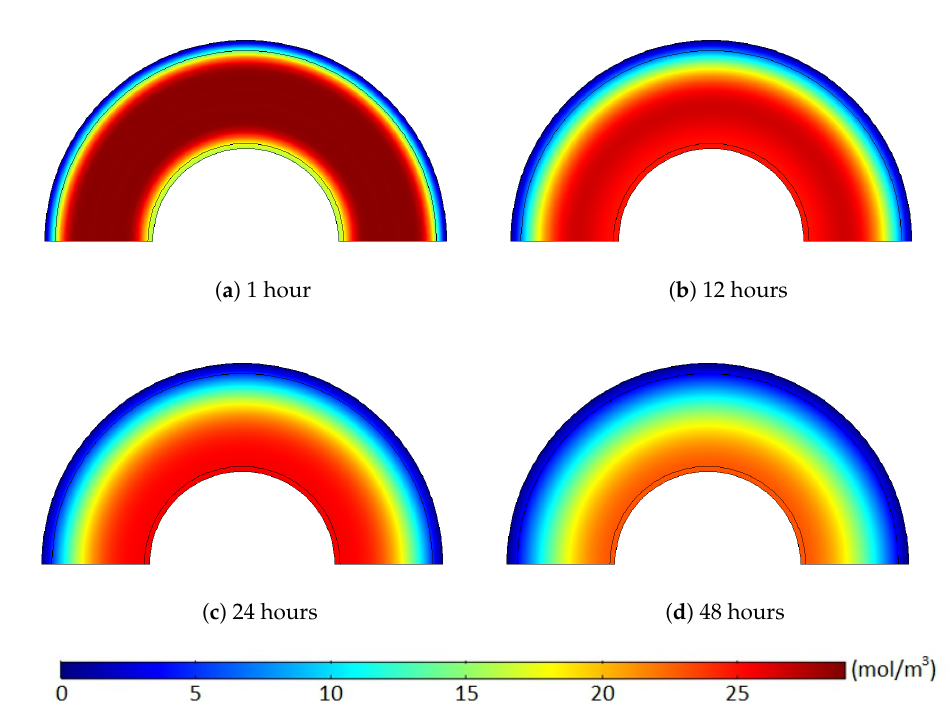
Figure 12. Methane concentration (mol/m 3 ) over time with the no-flow boundary condition where the target degassing chamber temperature is 343.15 K and C l = 1/90. ( a ) 1 hours, ( b ) 12 hours, ( c ) 24 hours, ( d ) 48